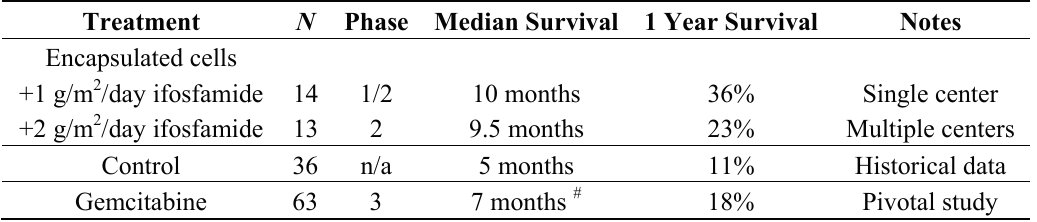
Table 5. Summary of survival data for patients receiving encapsulated cells followed by low-dose